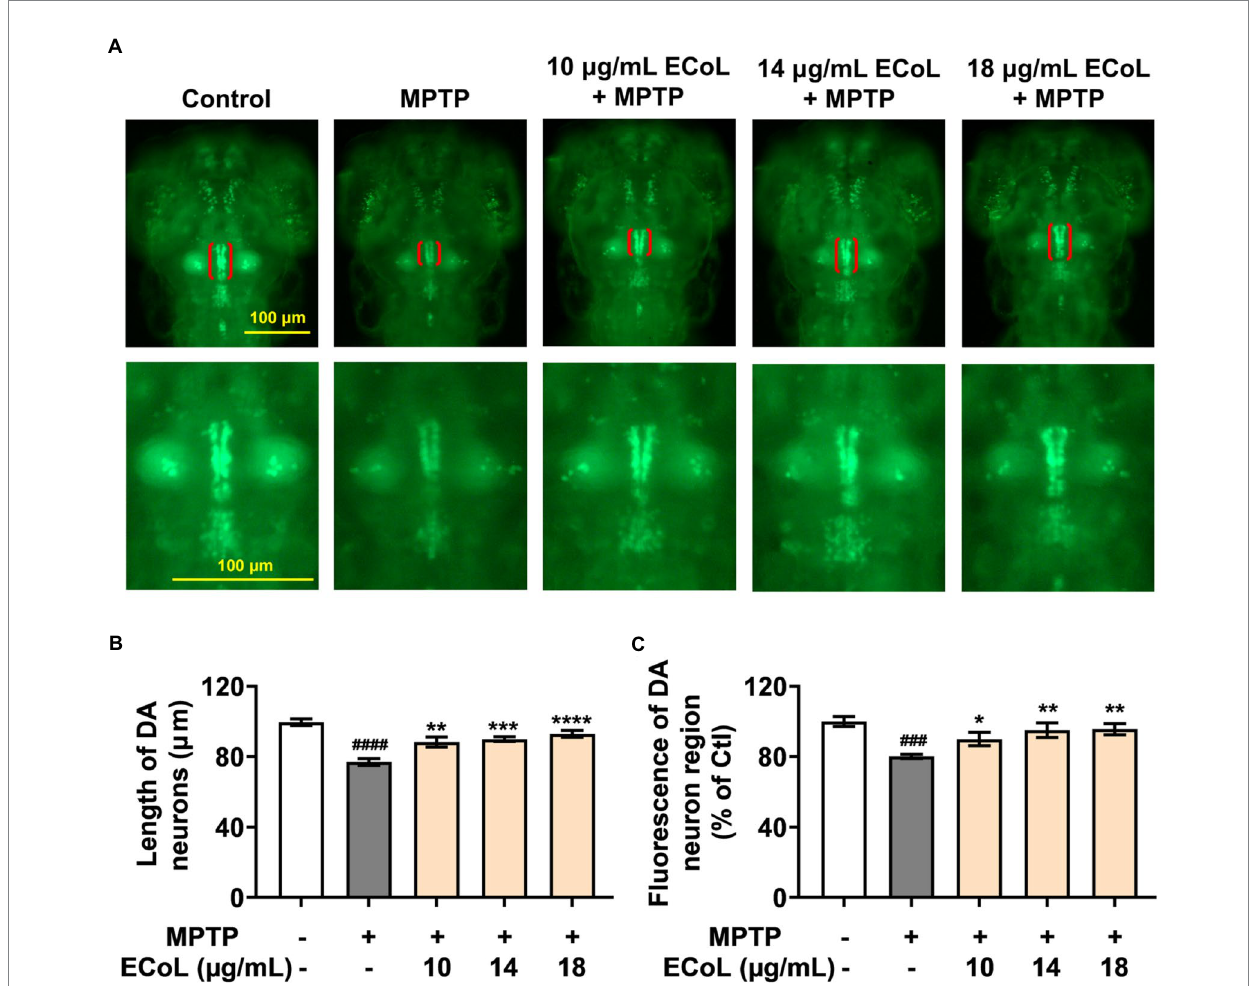
FIGURE 2 Remissive effect of ECoL on MPTP-induced DA neurons loss. (A) Representative fluorescent microscopy images of vmat2:GFP zebrafish in Control, MPTP, and ECoL+MPTP co-treatment groups. DA neurons are indicated by the red brackets. Enlarged images are shown to improve the morphologic visualization of DA neurons. Scale bar, 100 μ m. (B) Statistical analysis of the length of DA neurons region in each group, n = 8. (C) Statistical analysis of the fluorescence of DA neuron region in each group, n = 8. ### p < 0.001, #### p < 0.0001 vs. Control; * p < 0.05, ** p < 0.01, *** p < 0.001, **** p < 0.0001 vs.